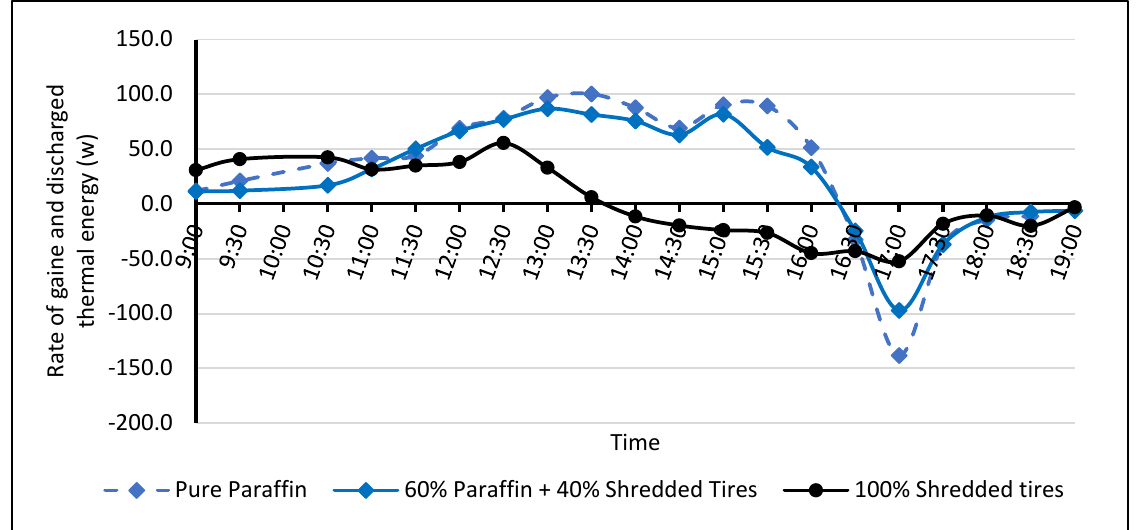
Figure 7. Comparison of thermal storage capacity of pure paraffin wax and the composite of 60% vol. paraffin wax + 40% vol . shredded tires.